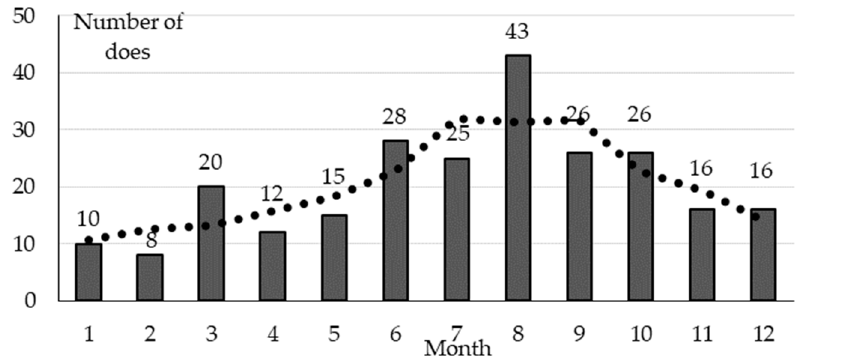
Figure 2. Monthly distribution of 245 necropsies with uterine torsion performed on 87 rabbitries from 1996 to 2014 and rolling average for three months (dotted line). Unpublished data derived from Rosell and de la Fuente [22].